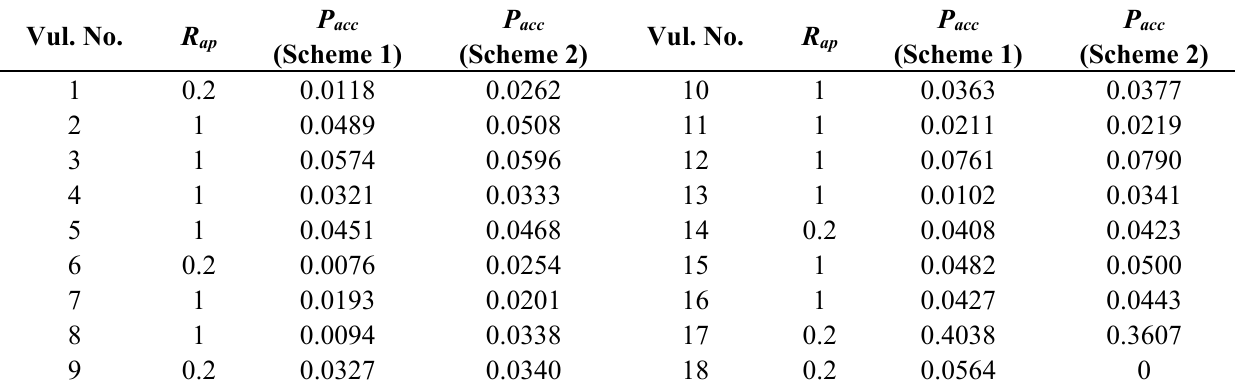
Table 4. Selecting access point.